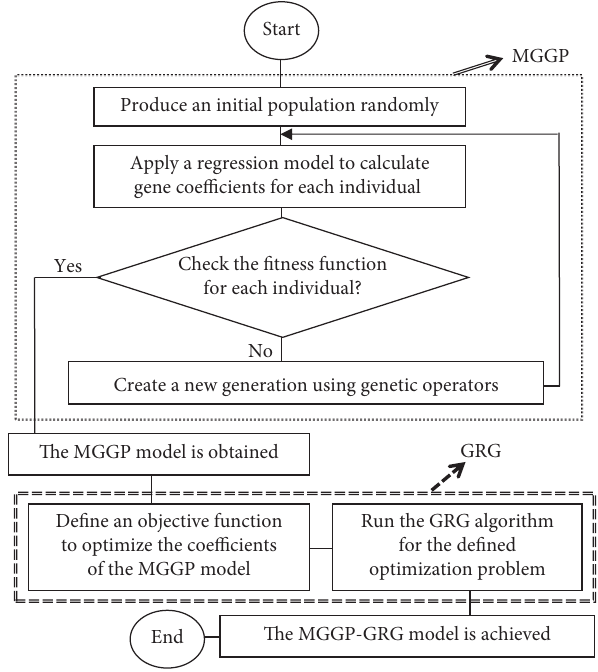
Figure 2: Flowchart of the hybrid MGGP-GRG for estimating infiltration